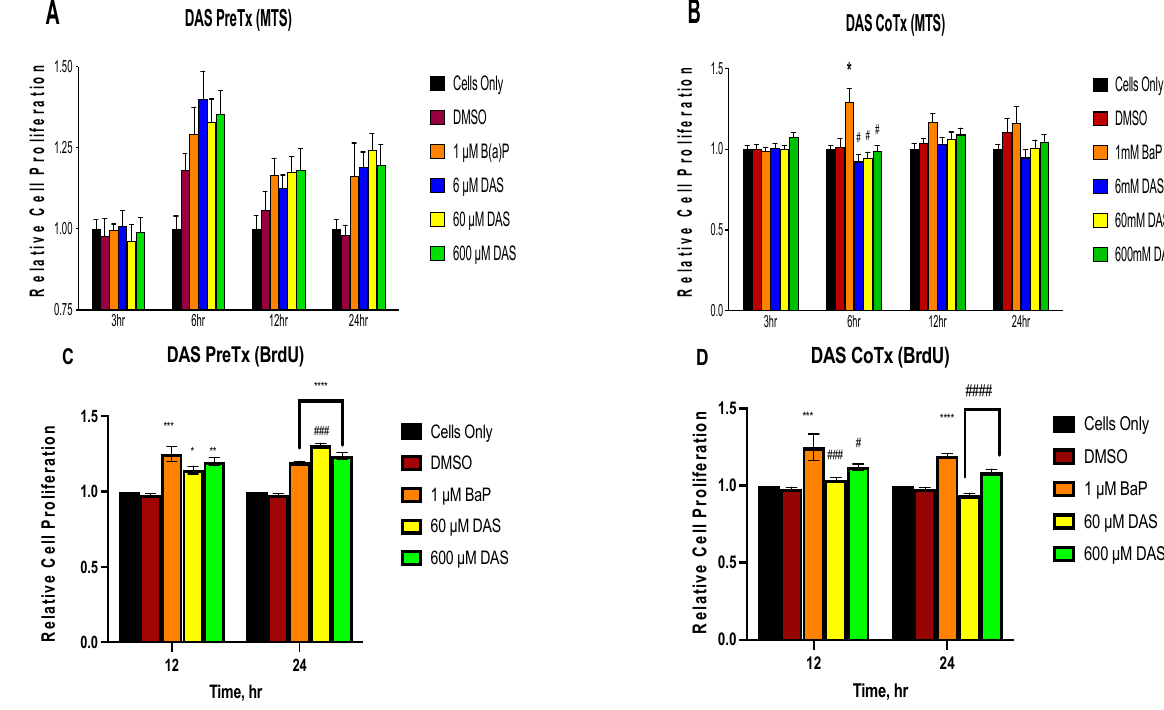
Figure 1. Relative cell proliferation (fold changes) of cells treated with DAS and BaP. MCF-10A cells were treated with 1 µ M BaP only, PreTx ( A , C ) or CoTx ( B , D ) with DAS (6, 60, and 600 µ M) during BaP (1 µ M) exposure for 3, 6, 12, and 24 h. Cell proliferation was assessed using MTS ( A , B ) and BrdU incorporation assay ( C , D ). The absorbance of each treatment group was normalized to the cells only control. The control is expressed as one-fold growth for each time point. The graph represents the average relative cell proliferation of triplicate values ± SEM. (* indicates p < 0.05, ** p < 0.01, *** p < 0.001, **** p < 0.0001 significant difference compared to DMSO control, and # p < 0.05, ### indicates p < 0.001, #### indi- cates p < 0.0001 significant difference when compared to 1 µ M BaP treatment using Bonferroni’s multiple comparison correction